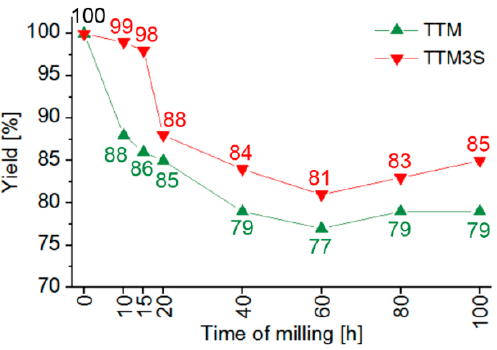
Figure 2. Process yield characteristics of Ti10Ta8Mo and Ti10Ta8Mo3Sn (wt %) powders after 10, 15, 20, 40, 60, 80 and 100 h of milling.